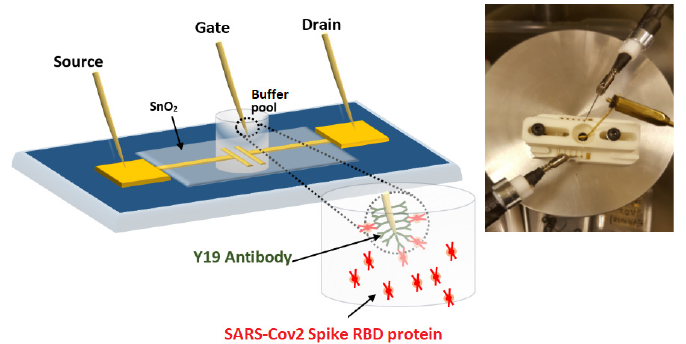
Figure 1. Schematic view of our WGTFT biosensor. ‘Y19 ′ stands for the antibody (immunoglobuline, IgG1) specific to the SARS-CoV-2 virus. The inset shows the practical implementation in a 3D-printed gating pool.